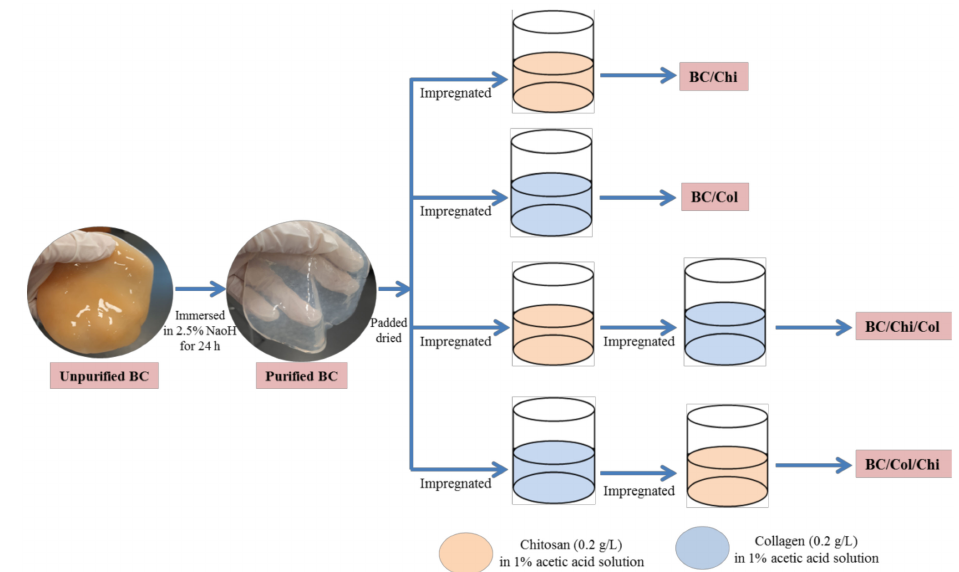
Figure 1. Schematic illustration of the BC-based wound dressing fabrication